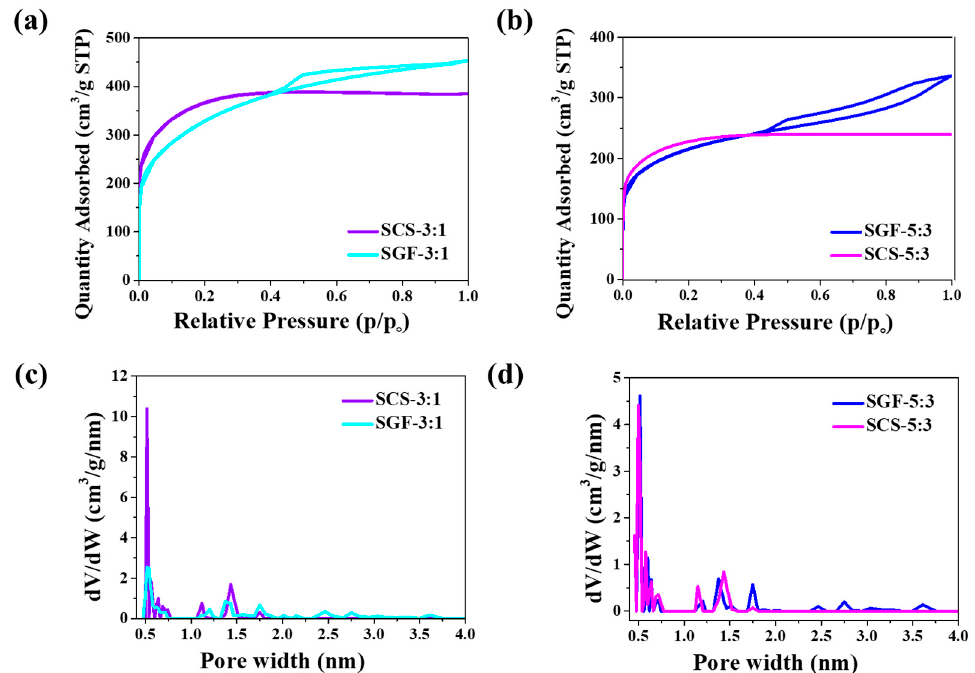
Figure 2. ( a , b ) N 2 adsorption–desorption isotherms at 77 K; ( c , d ) nonlocalized density functional theory (NLDFT) pore size distribution obtained from adsorption branches of N 2 in the SGF-R and SCS-R samples.